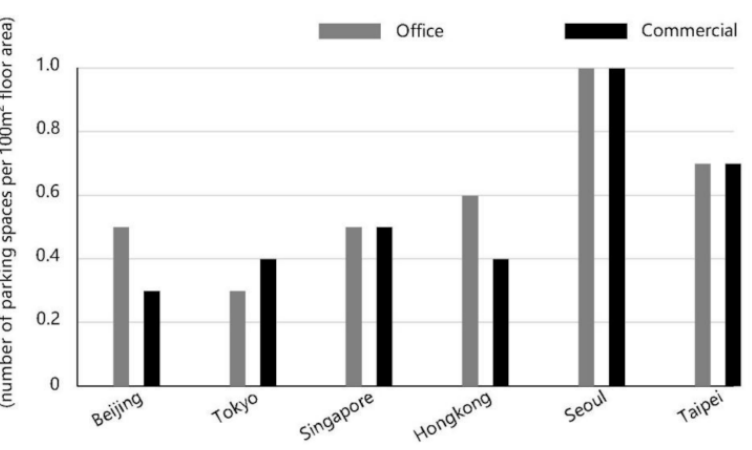
Figure 2. Parking space allocation index in Asian cities (adapted from